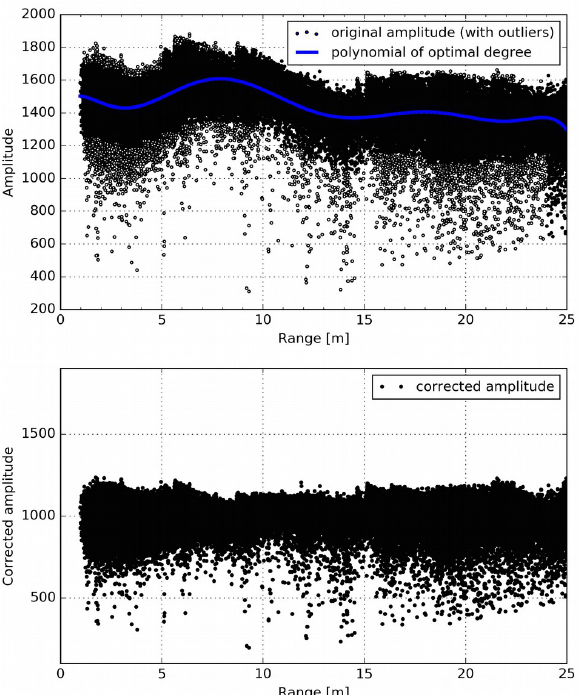
graphFigure 2. Amplitude correction by fitting a polynomial. Top: The original amplitude plotted against range. The lighter non filled dots indicate outliers. Bottom: the corrected amplitude centred at a value of 1000.